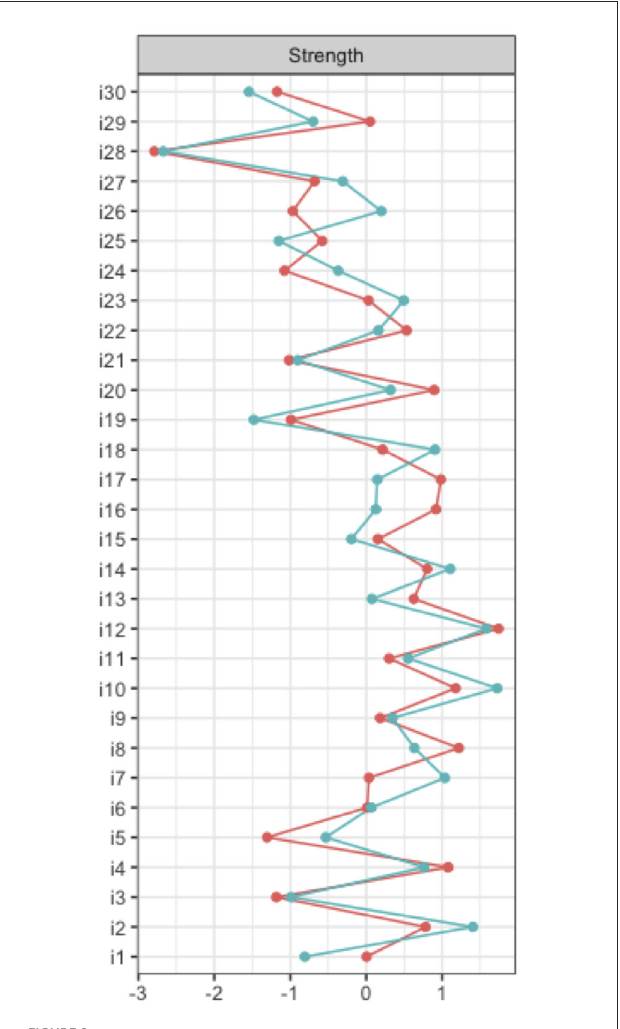
FIGURE2 Node strength NMSS